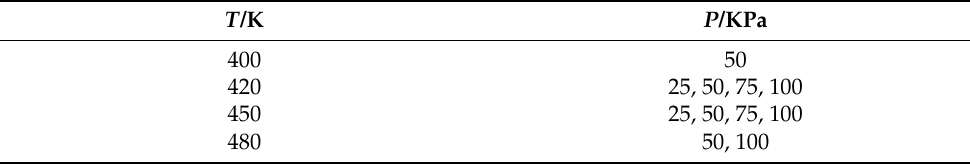
Table 1. Temperature and pressure conditions applied during experimental trials.